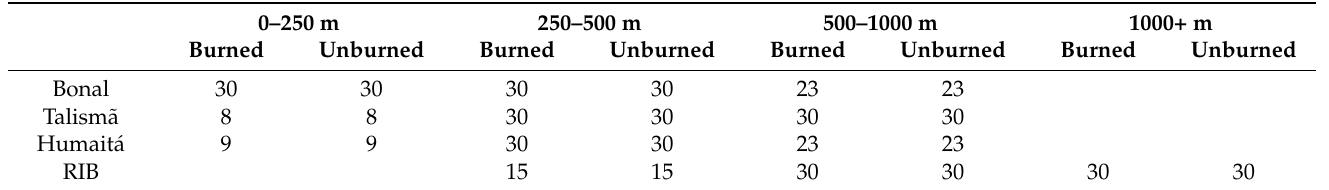
Table 3. Stratified sample numbers for burned and unburned areas by distance from forest edge class across study